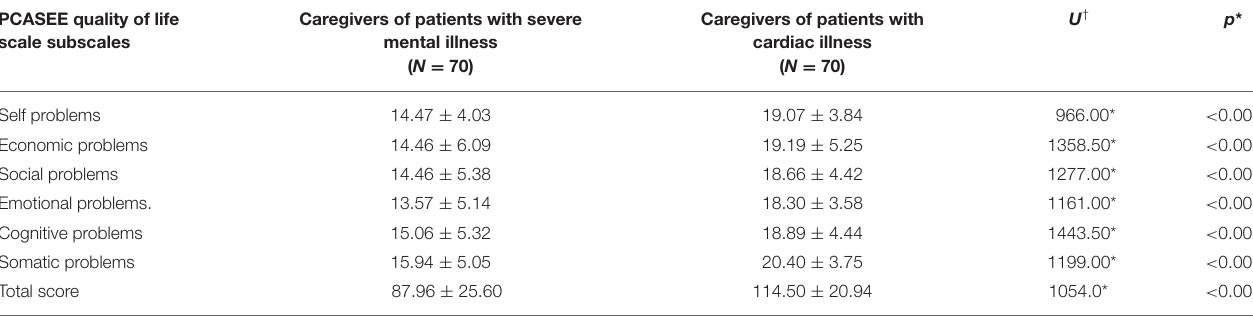
TABLE 3 | Self-reported quality of life of caregivers of patients with severe mental illness and cardiac illness (ischemic cardiac disease complicated with chronic heart failure). PCASEE quality of life scale